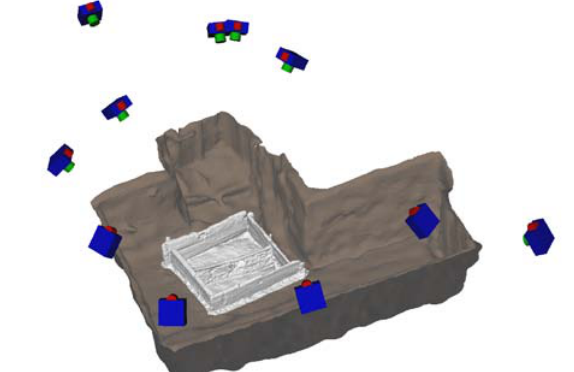
Figure 3. Positions of the digital cameras after bundle adjustment